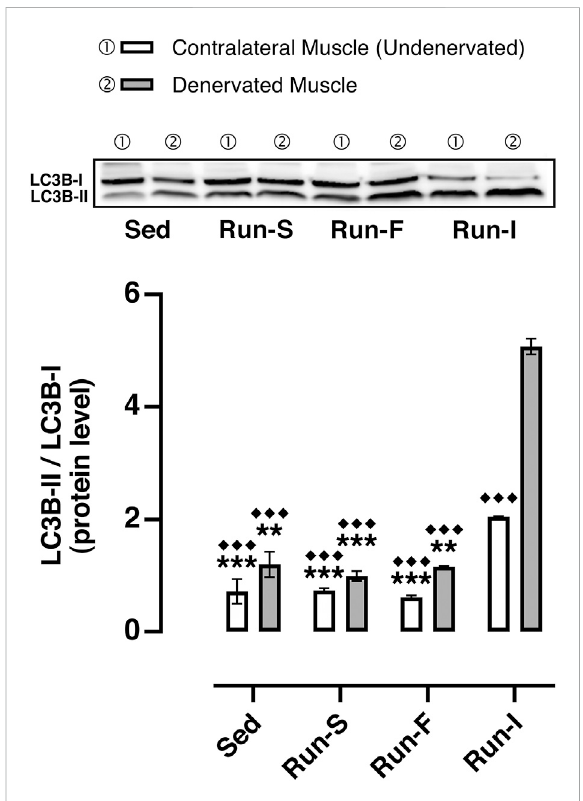
FIGURE 6 Effect of different exercise protocols on soleus muscle autophagy machinery after nerve crush. Representative western blot of LC3B-I and LC3B-II (top); quanti fi cation of protein levels of LC3B-II based on the ratio between the content in forms II and I of LC3B (bottom). Two-way ANOVA, main effect type of exercise: F (3, 16) = 218.3, p < 0.001; main effect of denervation: F (1, 16) = 143.4, p = 0.011; type of exercise-by-denervation interaction effect: F (3, 16) = 52.55, p < 0.001; Tukey ’ s post hoc test: ** p < 0.01 and *** p < 0.001 vs. Run-I (contralateral muscle), ◆◆◆ p < 0.001 vs. Run-I (denervated muscle). Data are expressed as mean and SEM (Denervated Muscle: Sed n = 3, Run-S n = 3,